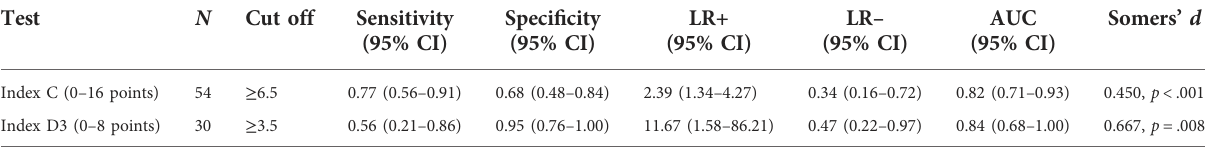
TABLE 4 Metrics for Index C and Index D3 from the model validation samples for predicting fall status at 3-months post discharge. Cut off scores established from the model derivation were applied to the validation samples. Values above the cut off indicate high fall risk. Somer ’ s d is for the binary variable using the indicated cut-off scores.